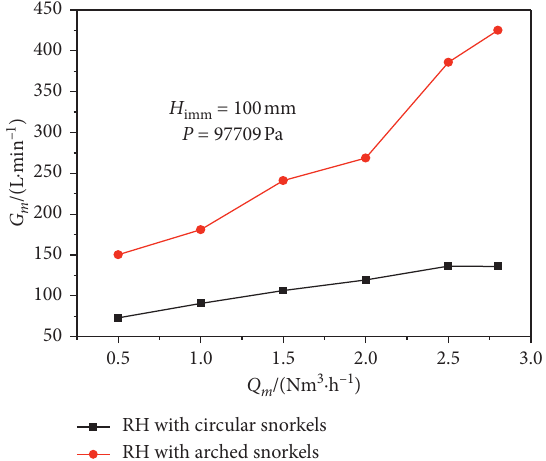
Figure 7: Relationship between G m and Q m in RH with arched snorkels and RH with circular snorkels.